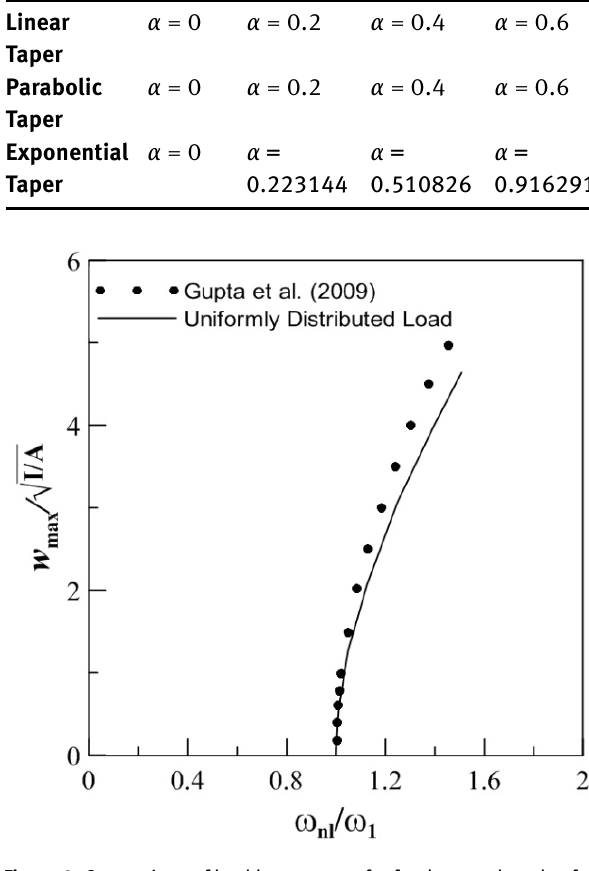
Figure 2: Comparison of backbone curves for fundamental mode of a clamped-clamped homogeneous uniform